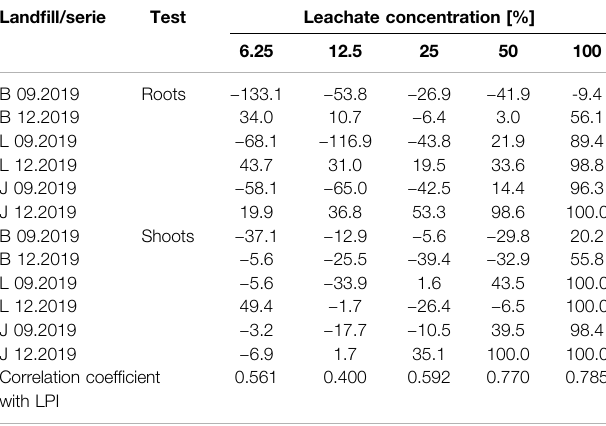
TABLE 6 | Toxic effect values (calculated from inhibition of root and shoot growth) and correlations between toxic effect values and LPI for analyzed leachate dilutions (marked values are signi fi cant for p < 0.05, N (cid:1)